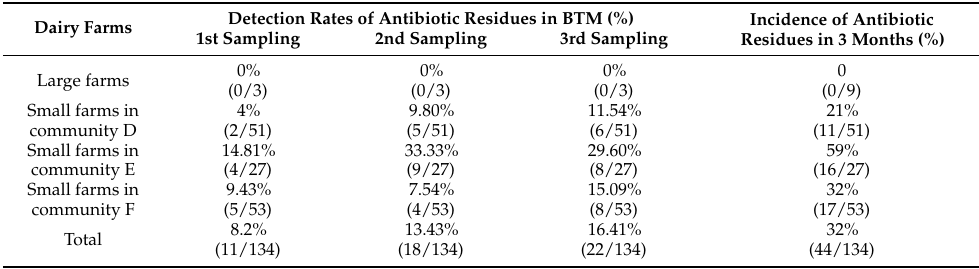
Table 5. Detection rates and incidence of antibiotic residues in bulk tank milk (BTM) of selected large scale and small holder dairy farms in 3 communities in Yunnan,